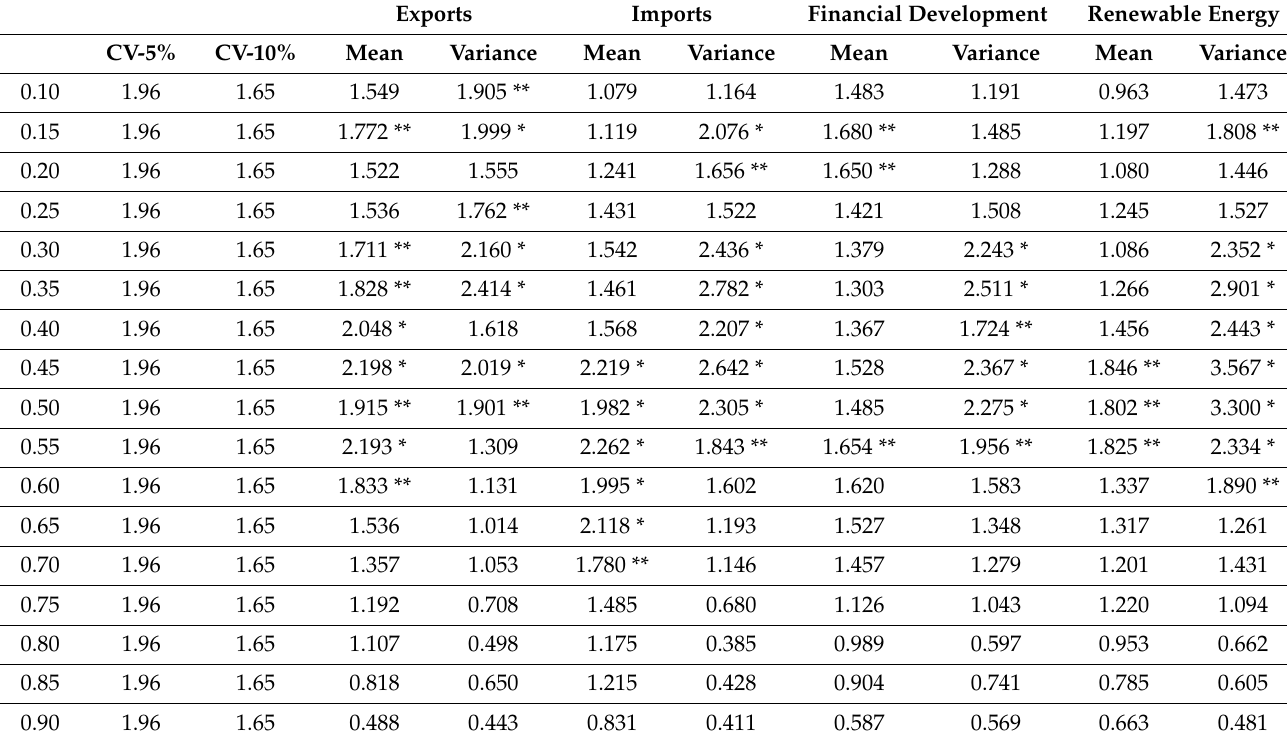
Table 6. Causality in mean and